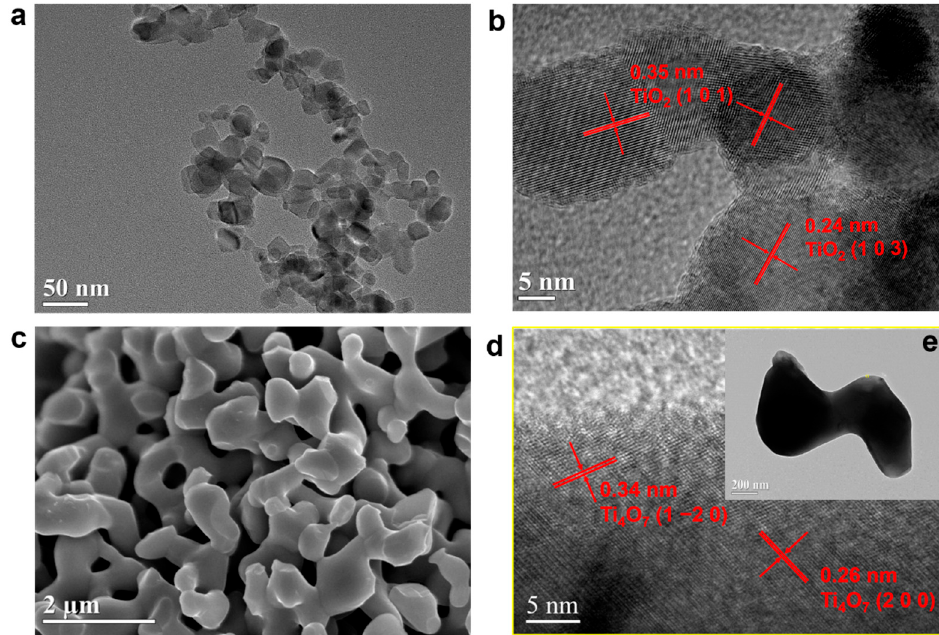
Figure 2. ( a ) TEM and ( b ) HRTEM images of P25 TiO 2 . ( c ) SEM, ( d ) HRTEM, and ( e ) TEM images of Ti 4 O 7